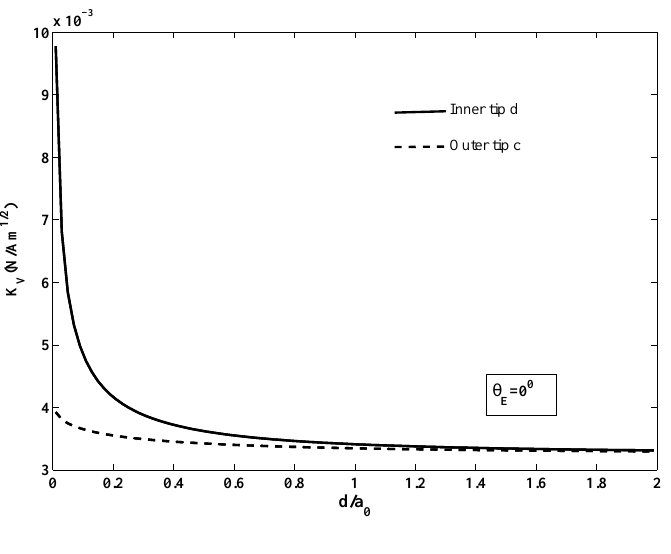
Fig. 17 MIIF versus inter-crack distance for different magnetic poling with fixed electric